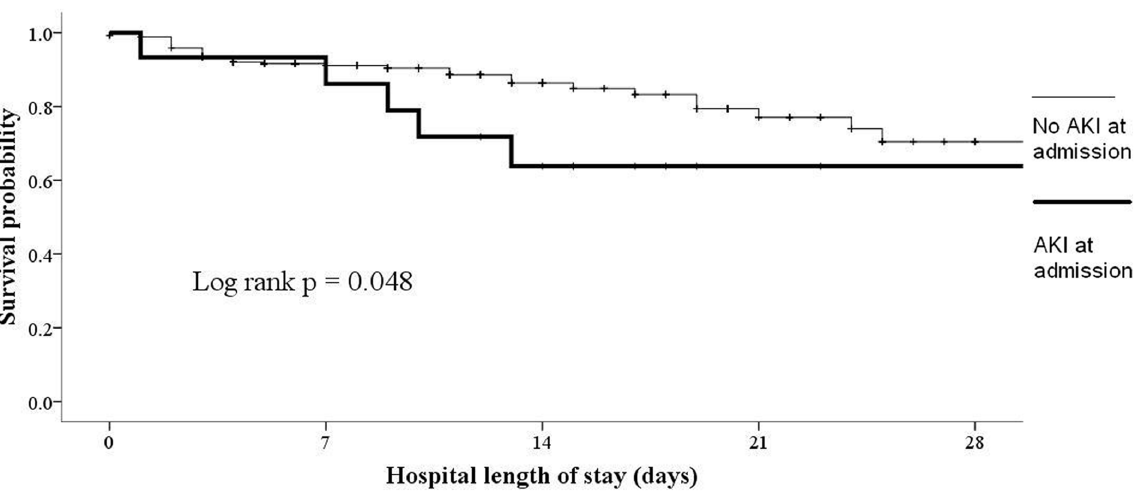
Figure 2. Kaplan-Meier survival curve based upon presence of AKI or not at admission. Abbreviation: AKI, acute kidney injury.